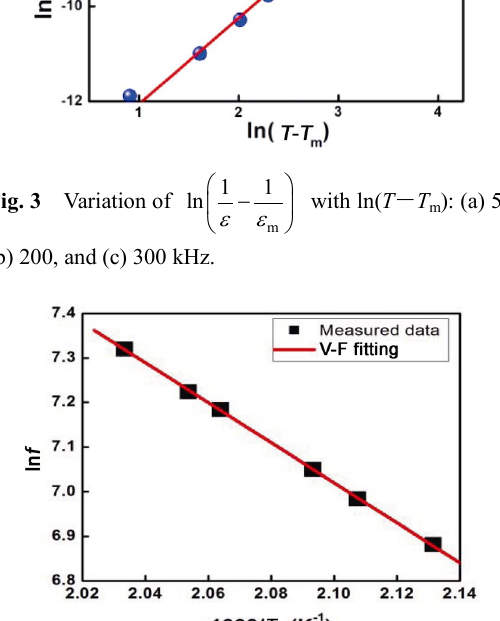
Fig. 4 Dependence of the ln f with 1000/ T m (Vogel – Fulcher